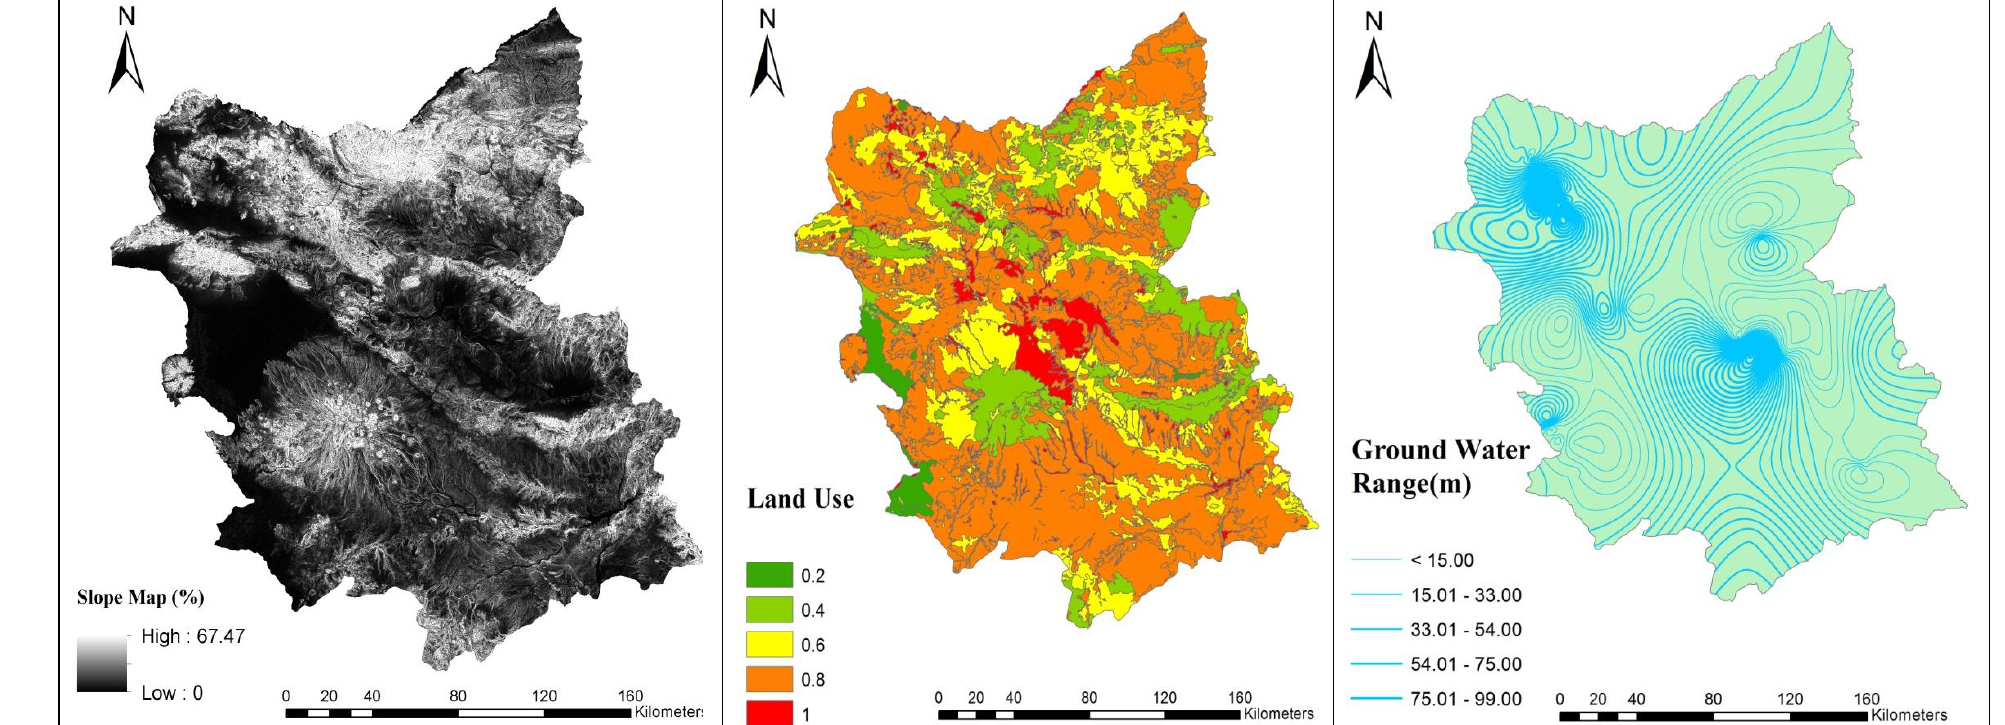
Figure A- Variation map of the effective parameters in drought vulnerability assessment, (a): Precipitation, Temperature and solar radiation range map, (b): Solar map, Land use